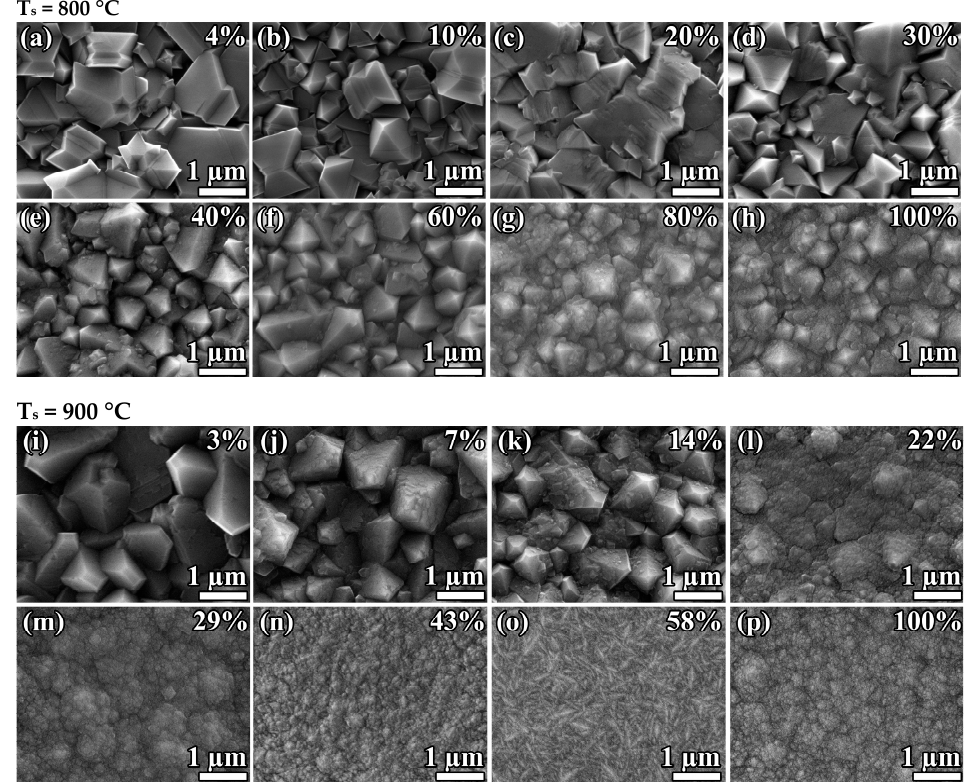
Figure 2. SEM images of polycrystalline diamond films synthesized at substrate temperatures T s = 800 ± 25 ° С ( a – h ) and 900 ± 25 ° С ( i – p ) and different CH 4 to total flow concentration 𝜈 𝑐 . Increasing the methane concentration leads to the MCD-to-NCD transition. However, the critical methane-concentration-to-NCD transition depends on the substrate temperature. The MCD-to-NCD transition occurs earlier at higher substrate temperatures. shifts to the region of 𝜈 (cid:3030) = 70%. Note that the synthesis regime at 900 °C and 𝜈 (cid:3030) = 43% series at the same temperature (Figure 1e), the NCD-to-graphite transition has already occurred. We explain this by the fact that, in the first series, the NCD-to-MCD transition occurred just between samples 850 and 900 °C (Figure 1d,e), i.e., 850–900 °C is the thresh- old temperature at 𝜈 (cid:3030) = 40%. Thus, we consider the conditions of T (cid:2929) = 900 °C and 𝜈 (cid:3030) = 40% to be a borderline between NCD and MCD regimes, so even slight deviations may lead to a change in the type of grown material. This means that there is no disagreement, taking into account the error in temperature control. In addition, note that, at 800 °C, even in pure methane gas (methane concentration of 100%), the deposition of NCD diamond films is possible. 3.2. X-ray Diffraction The third series of experimental samples (grown at a fixed T (cid:2929) = 900 °C) was chosen for XRD analysis because it consists of texture PCD films and shows a transition from MCD to NCD. The X-ray diffraction patterns recorded in the standard θ /2 θ scanning mode had a wide range of peaks caused by the decomposition of the X-ray tube spectrum on a single-crystal Si (100) substrate. A scanning mode was chosen with a deviation in the substrate plane from the position 2 θ /2 by 3°, which makes it possible to eliminate the re- flection from the substrate. The XRD pattern for the PCD films synthesized at substrate temperatures T (cid:2929) = 900 ± 25 ° С and different CH 4 concentration 𝜈 (cid:3030) (Figure 3a) demon- strates four reflexes for diamond from crystallographic planes (111) at 2 θ = 43.93°, (220) at 75.30°, (311) at 91.49°, (400) at 119.50° and (331) at 140.56°, and a wide set of peaks caused by the decomposition of the X-ray tube spectrum on a single-crystal Si (100) substrate in the region 2 θ ~69°.